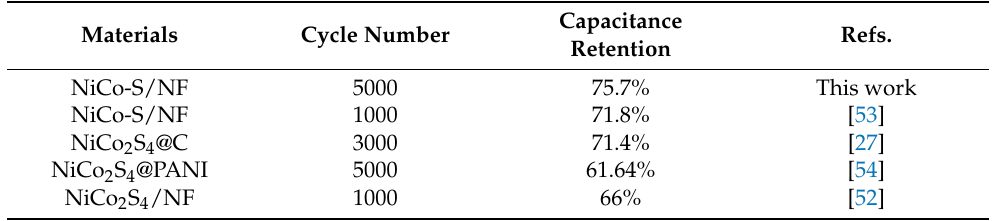
Table 3. Comparison of capacity retention rate of electrode materials after long cycle with other studies in the